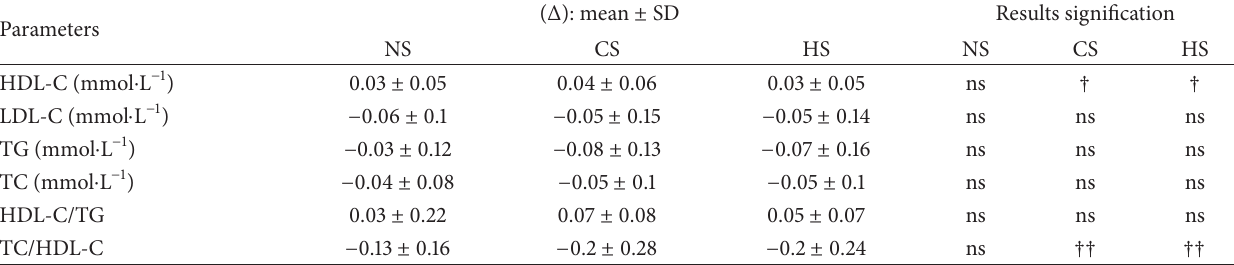
Table 5: Lipid improvement rate ( Δ ) of the three groups after 12 weeks of intermittent training.